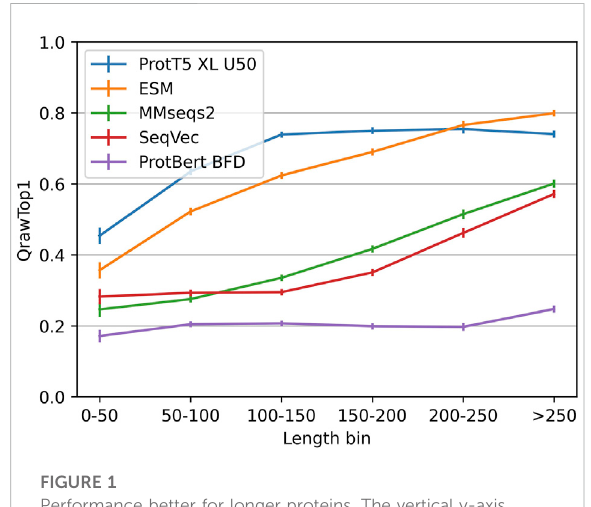
FIGURE 1 Performance better for longer proteins. The vertical y-axis QrawTop1 (Eq. 1) re fl ect the performance for proteins from the length interval speci fi ed on the horizontal x-axis (non-cumulative bins). While the embeddings from ProtT5 and ESM saturated quickly, the sequence alignment method MMseqs2 and the SeqVec-embeddings correlated more linearly with protein